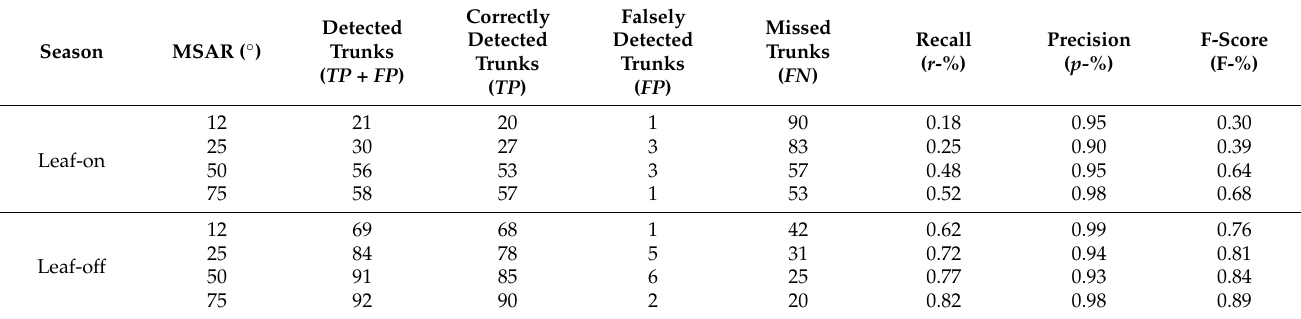
Table 2. Statistical analysis of the tree stem segmentation and classification procedures as a function of the season (leaf-on versus leaf-off) and the MSAR (12 ◦ , 25 ◦ , 50 ◦ , and 75 ◦ ).